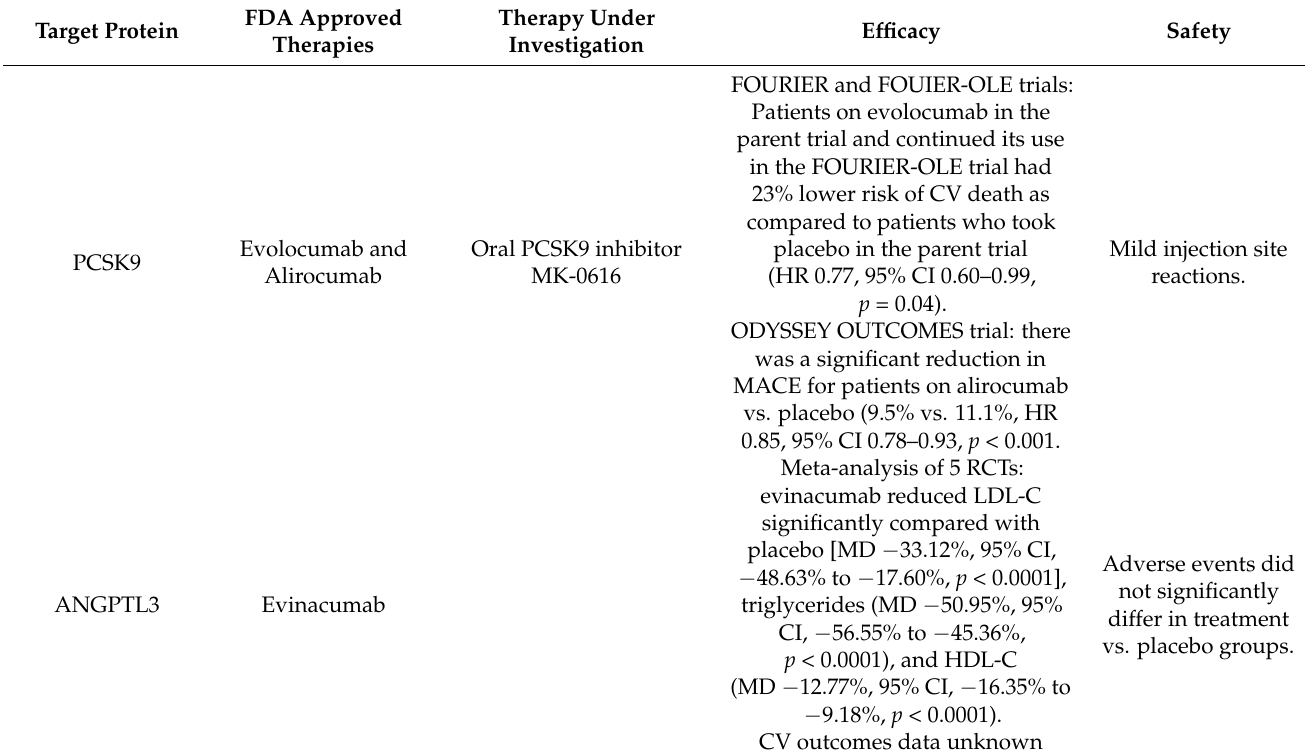
Table 1. Summary of monoclonal antibodies currently available or under